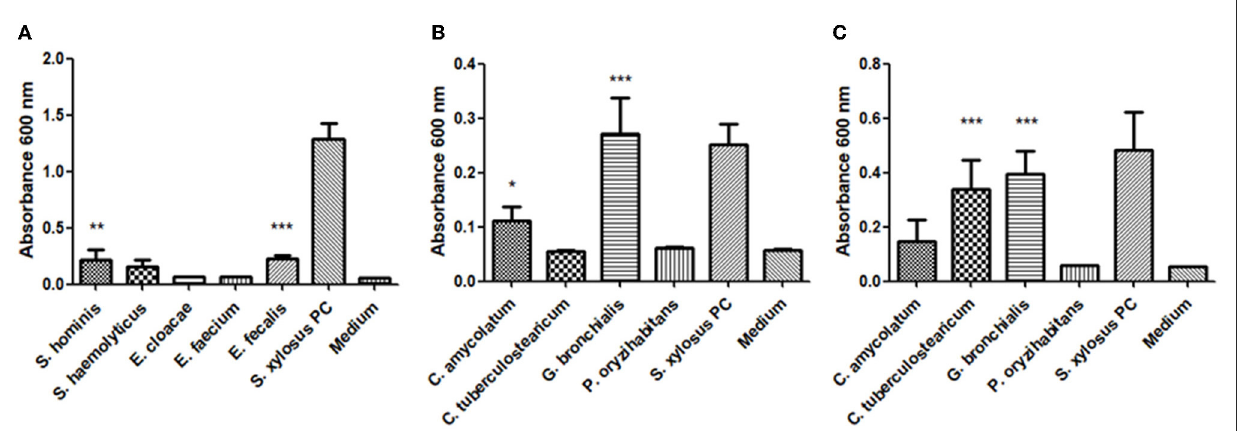
FIGURE2 The biofilm-forming capacity of strains isolated from a necrotizing ulcer: (A) S. hominis, S. haemolyticus, E. cloacae, E. faecium, E. faecalis, and S. xylosus PCM 2122 grown in BHI broth for 24h; (B) C. amycolatum, C. tuberculostearicum, G. bronchialis, P. oryzihabitans, and S. xylosus PCM 2122 grown in BHI broth for 48h; (C) C. amycolatum, C. tuberculostearicum, G. bronchialis, P. oryzihabitans, and S. xylosus PCM 2122 grown in TSB broth for 48h. Statistical significance was calculated using a one-way analysis of ANOVA, followed by Bonferroni’s multiple comparison test (* p < 0.05, ** p < 0.01, and *** p <